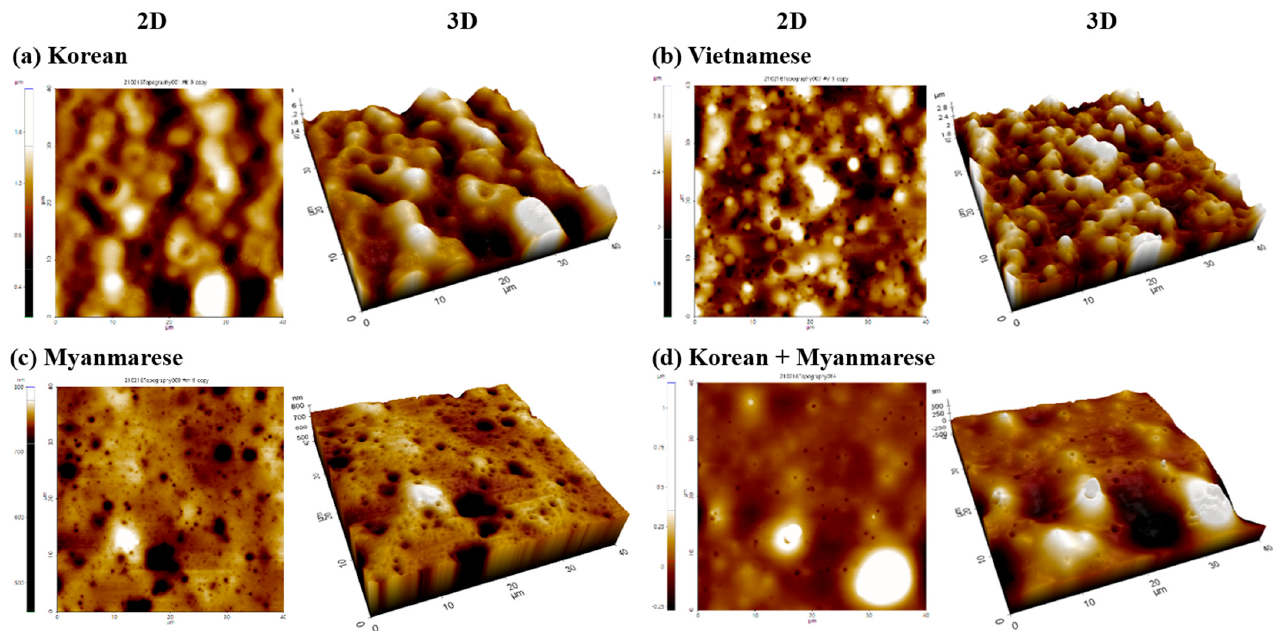
Figure 3. Two-dimensional and three-dimensional AFM images of Oriental lacquers after a drying time of 28 d: ( a ) Korean, ( b ) Vietnamese, ( c ) Myanmarese, ( d ) Korean/Myanmarese mixture (1/1, w / w ). Table 1. Atomic force microscopic evaluation of root-mean-square roughness ( R rms ) and average roughness ( R a ) of Oriental lacquer films. Sample (25 ◦ C, 85%